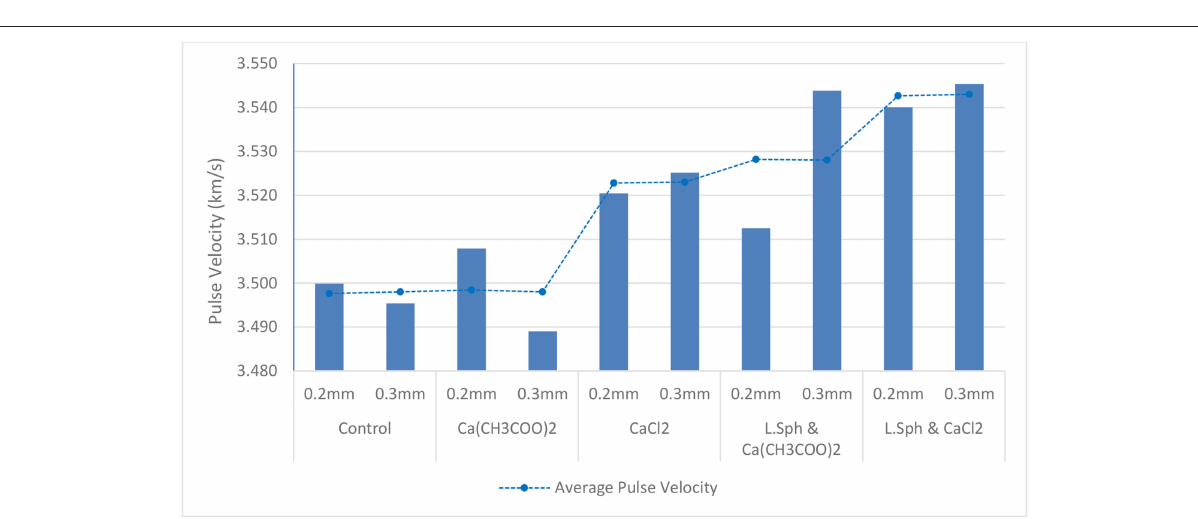
FIGURE 8 | Graph showing pulse velocity for cracked samples with 0.2 and 0.3mm cracks after Calcium source treatment with and without bacteria, compared to un-cracked un-treated control. The average pulse velocity for 0.2 and 03mm cracks is indicated as a dotted